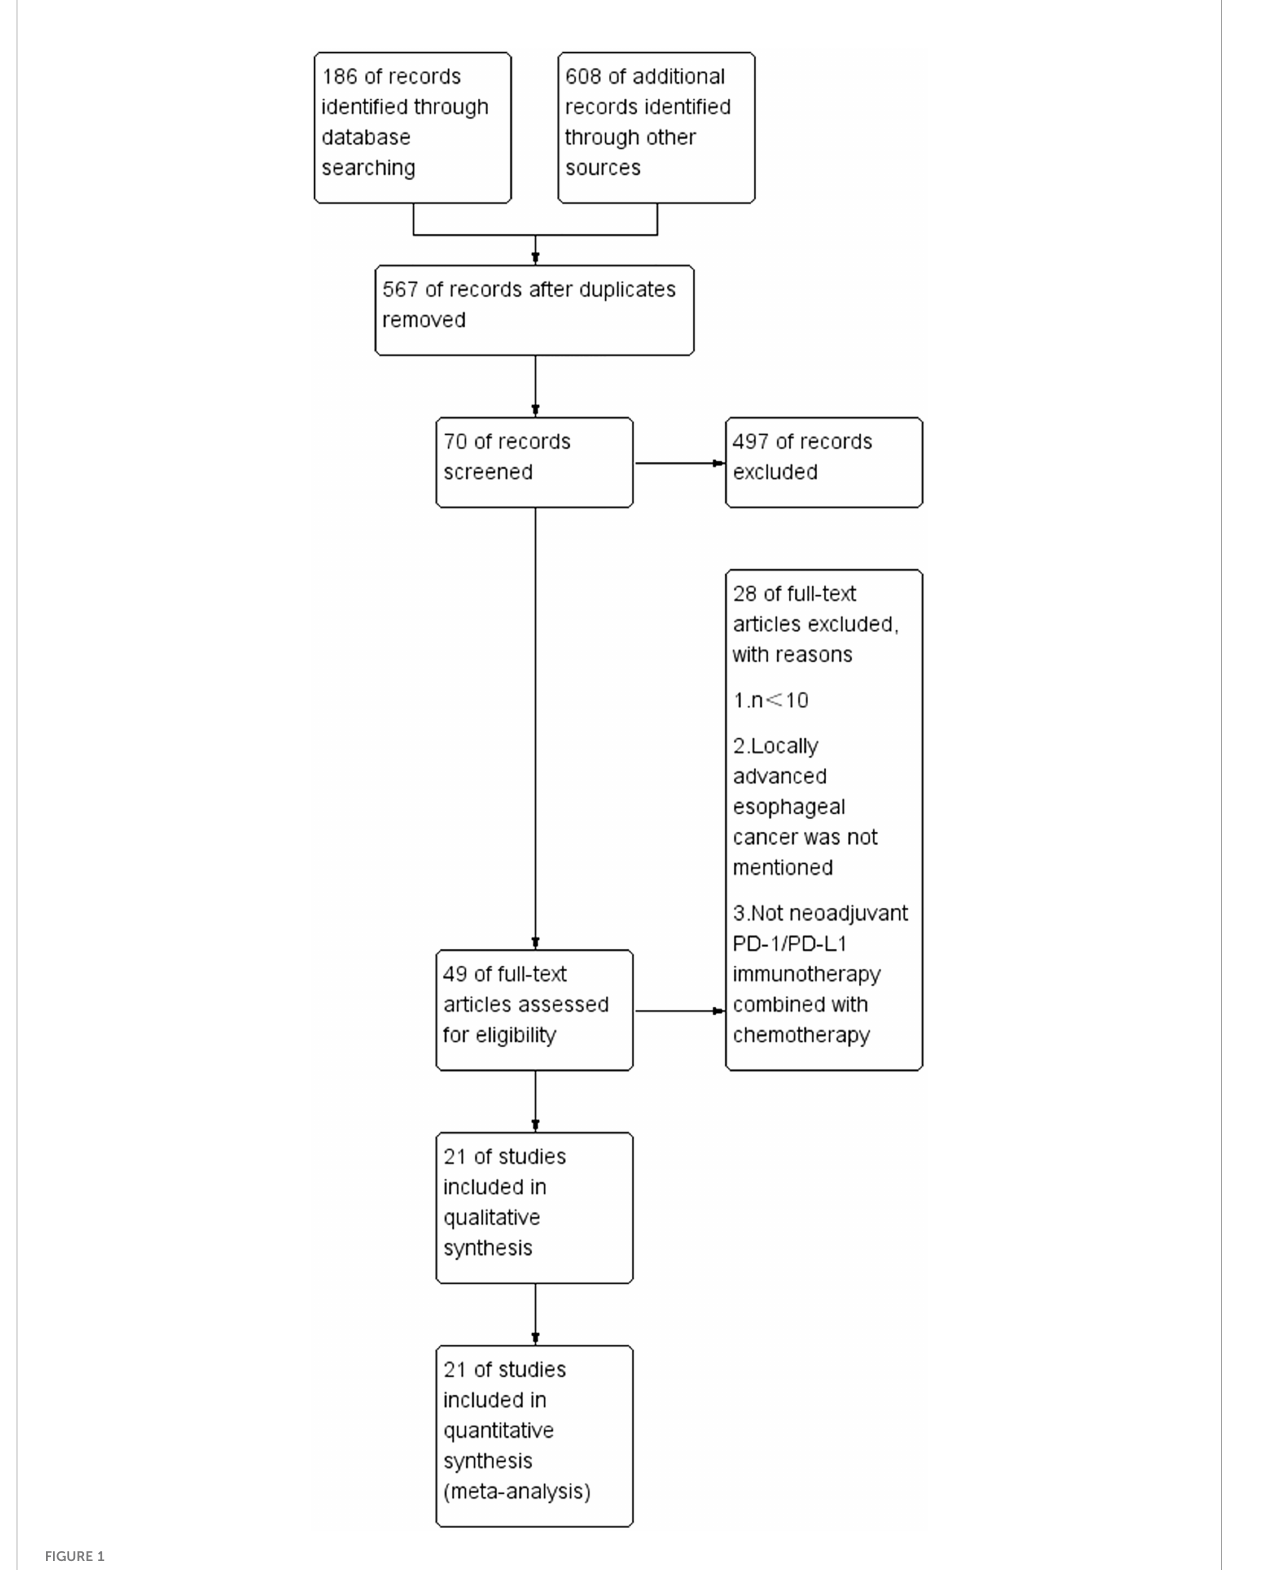
FIGURE 1 Publication